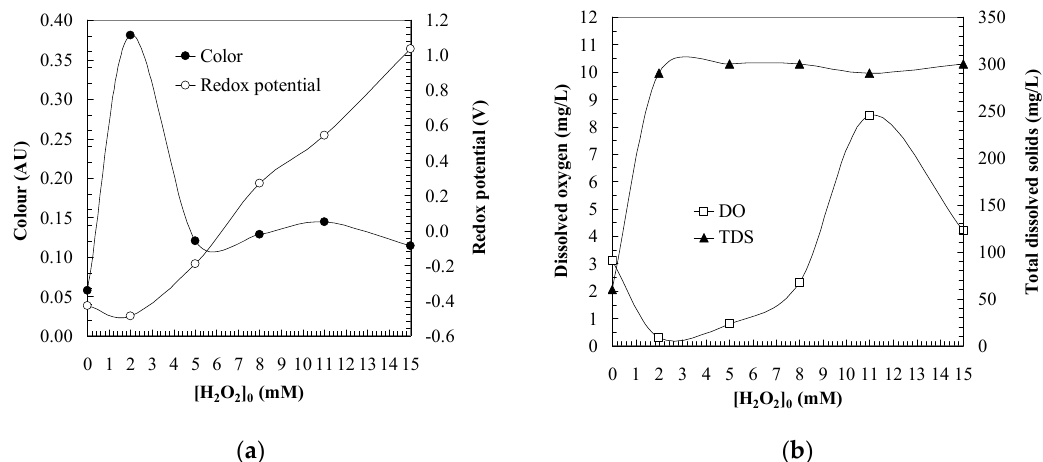
Figure 6. Indicator parameters of water quality analysed at the steady state: ( a ) Colour and redox potential. ( b ) Dissolved oxygen and total dissolved solids. Experimental conditions: [CBZ] 0 = 50.0 mg/L; pH = 3.0; [Fe] 0 = 10.0 mg/L; [UV] = 150 W; T = 40 °C.